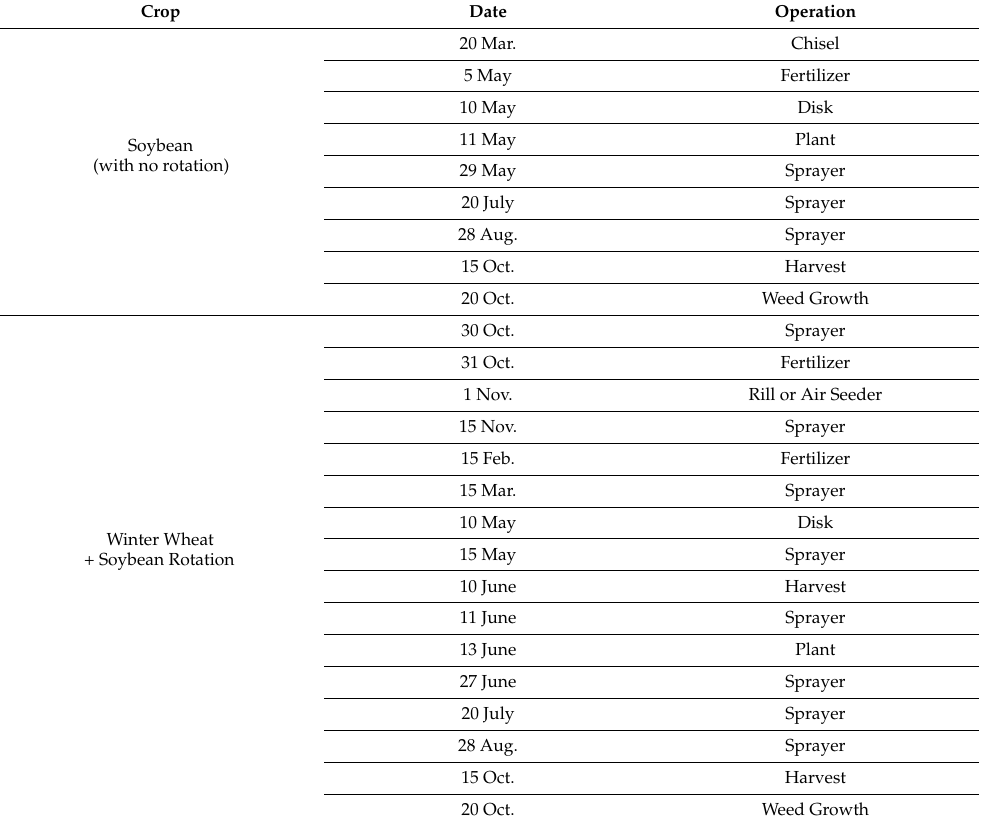
Table 3. Comparison of annual management schedule for soybean and soybean + winter wheat